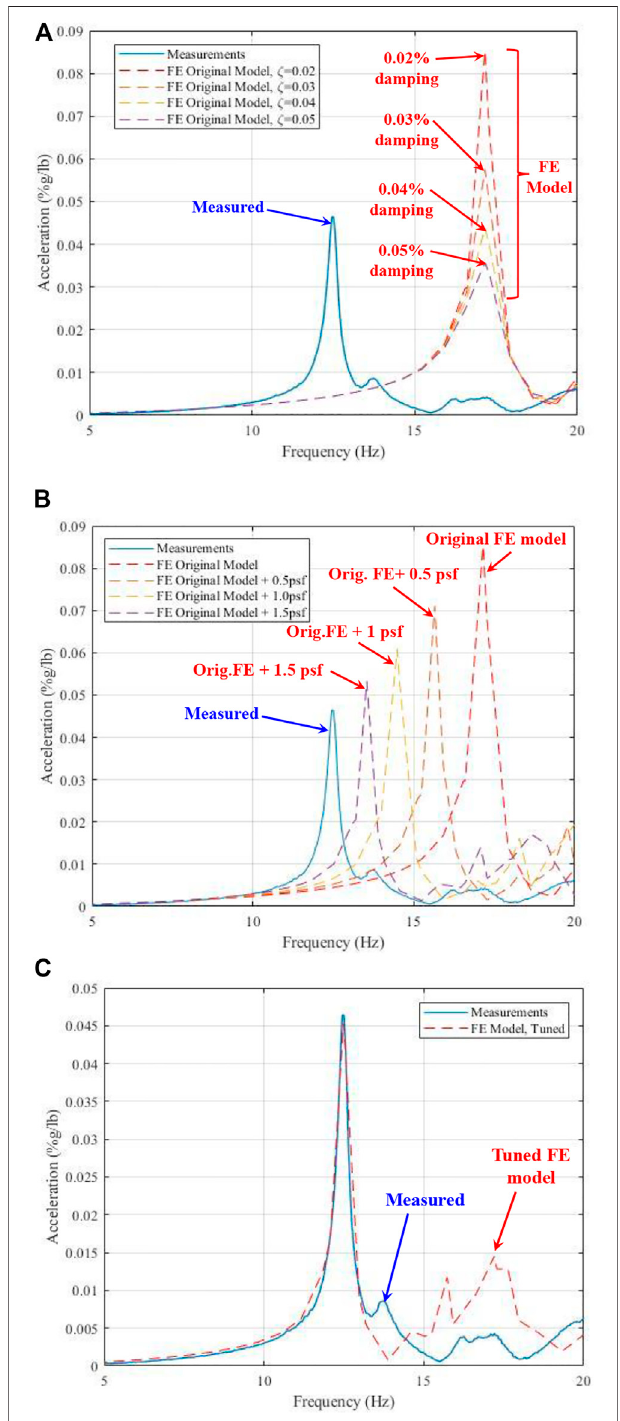
FIGURE 9 | Summary of the tuning process for the FE model. (A) Effect ofmodaldampingratioonthepredictedFRFmagnitude. (B) Effectofmasson predicted modal frequency. (C) FRF agreement between measurements and tuned FE model.